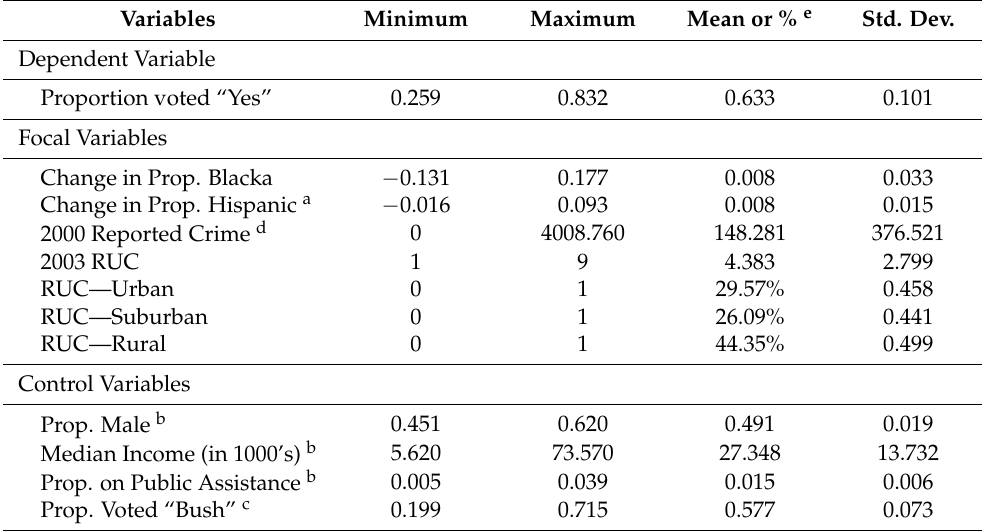
Table 1. Descriptive Statistics of Dependent and Independent Variables (N = 115).